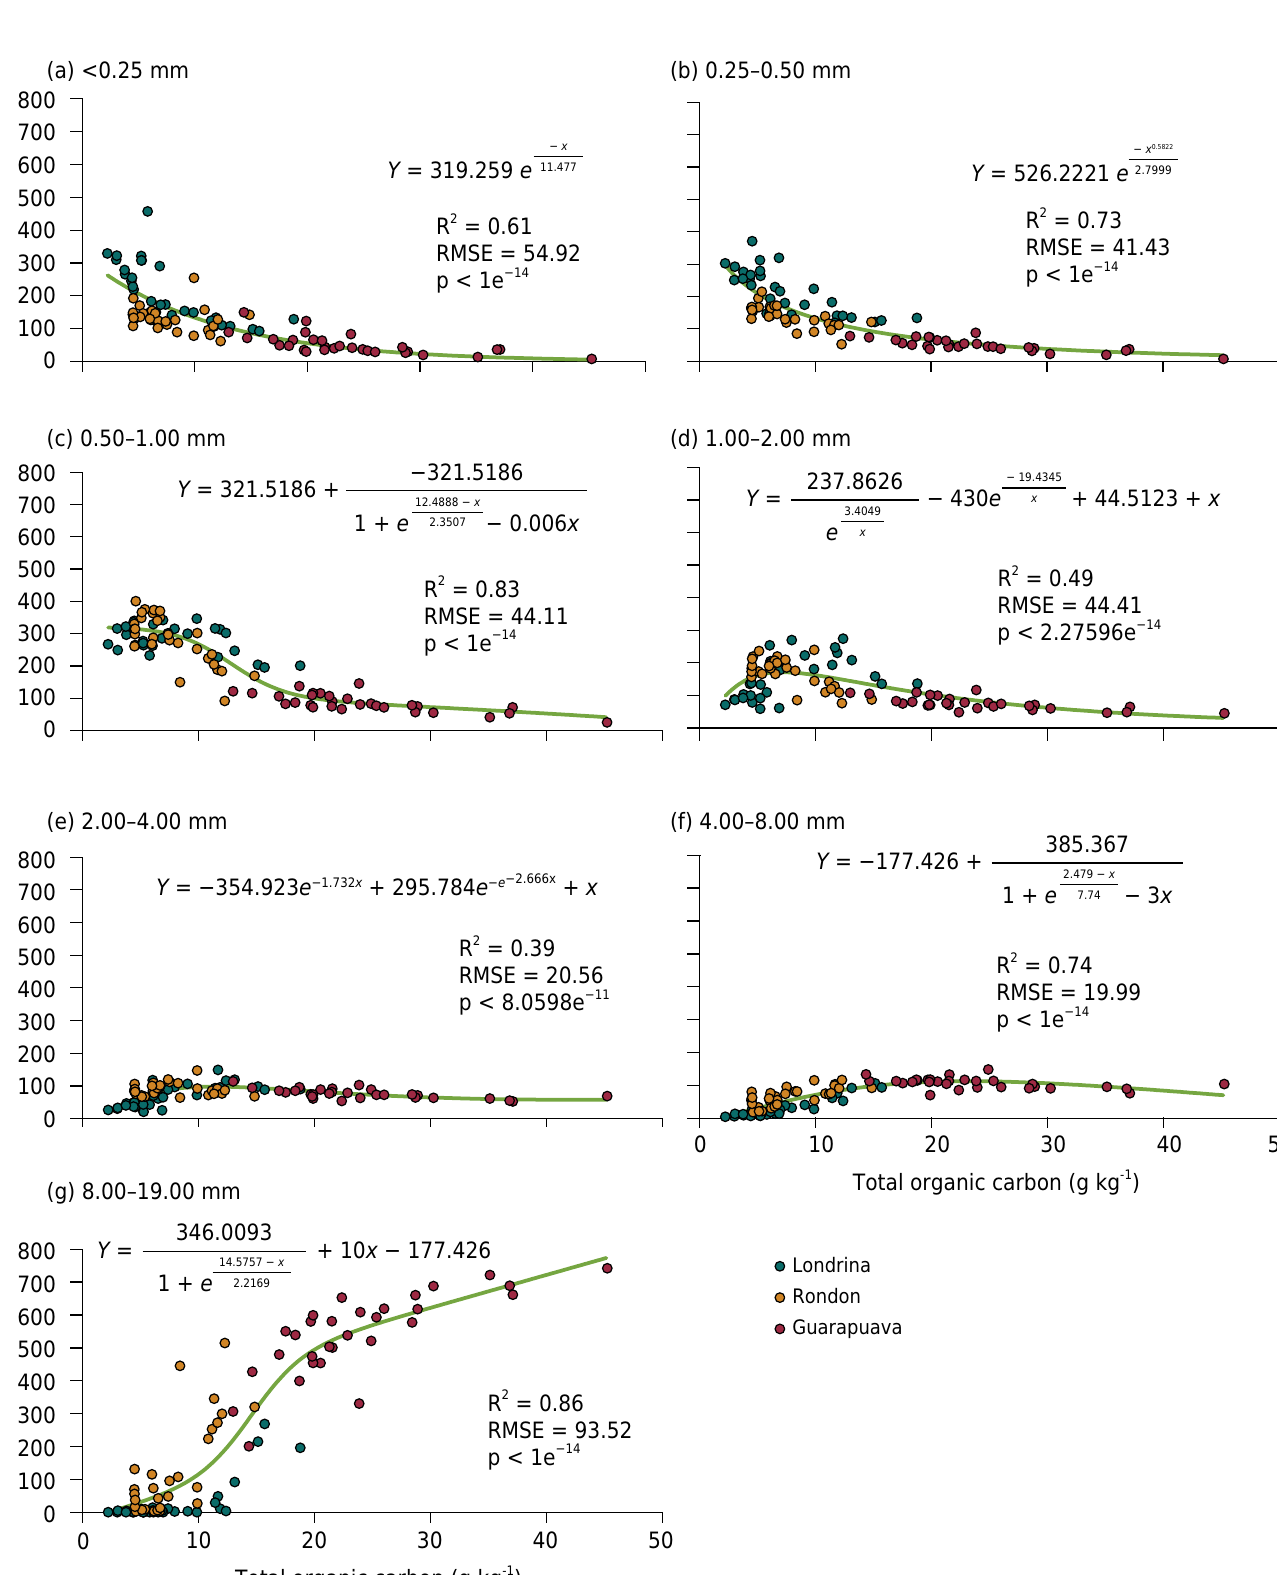
Figure 1. Mass of size classes of water-stable aggregates as a function of total organic